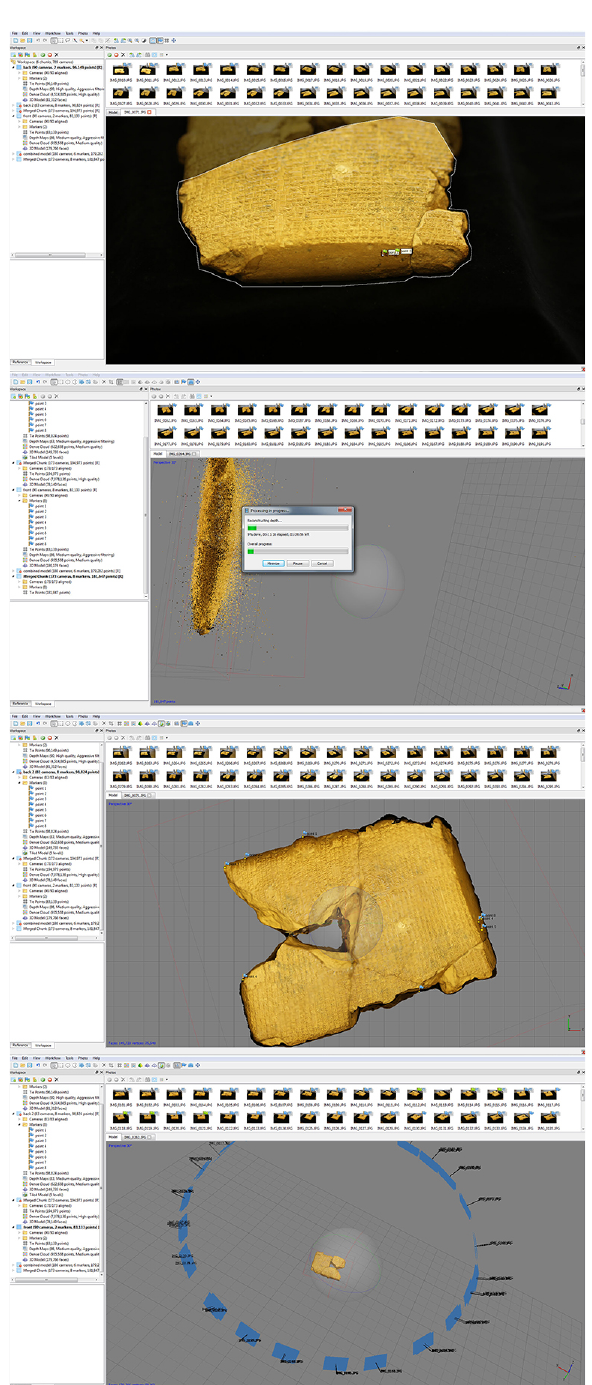
Figure 2. Screenshots from Agisoft Photoscan taken during